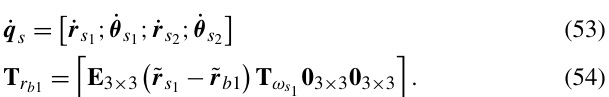
original length of a guy rope with known preload is